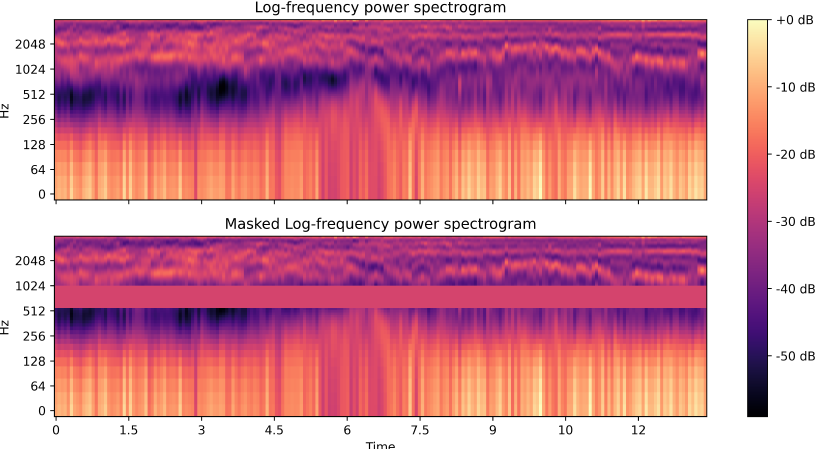
Figure 5. The original log-mel spectrogram of a vehicle recording and the masked log-mel